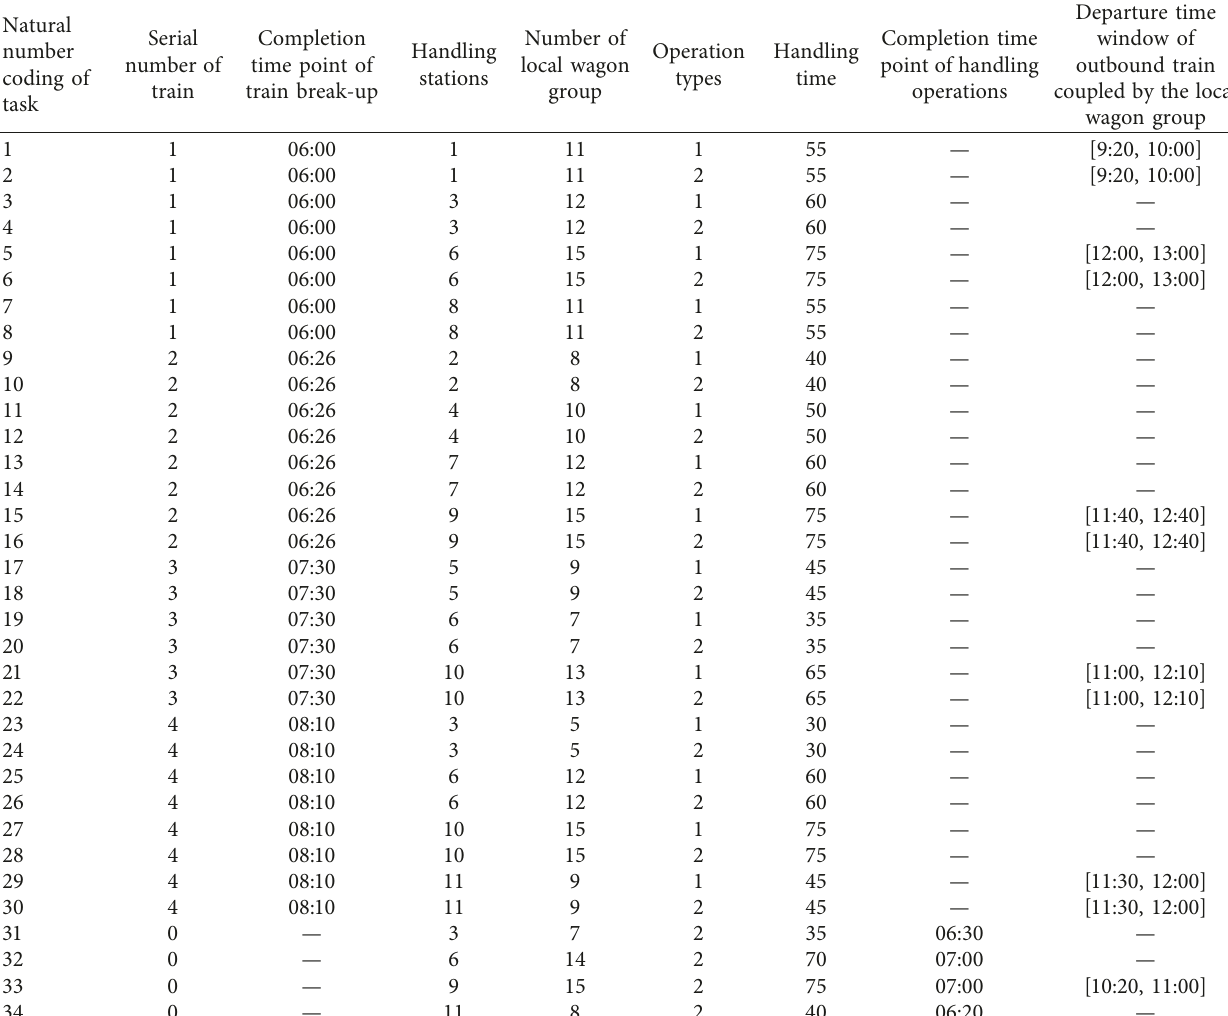
Table 3: Data of arrival train and wagon flow in railway terminal.